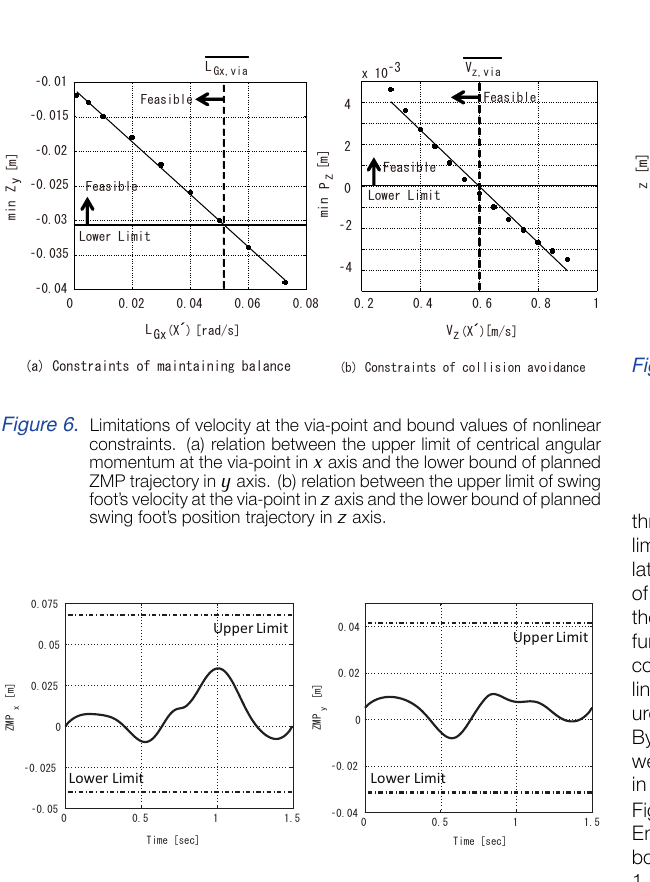
Figure7. ProfilesofZMPofplannedtrajectorieson x and y axesinEnvironment 2 (solid line: trajectories using proposed method; dash-dotted line: upper and lower limits of the support foot).